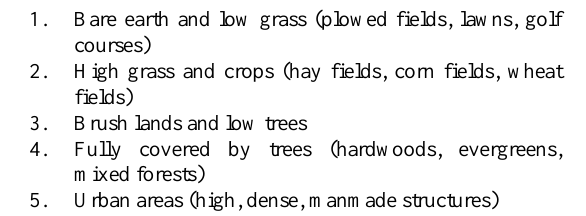
Table 1: Vertical Accuracy of the LiDAR Point